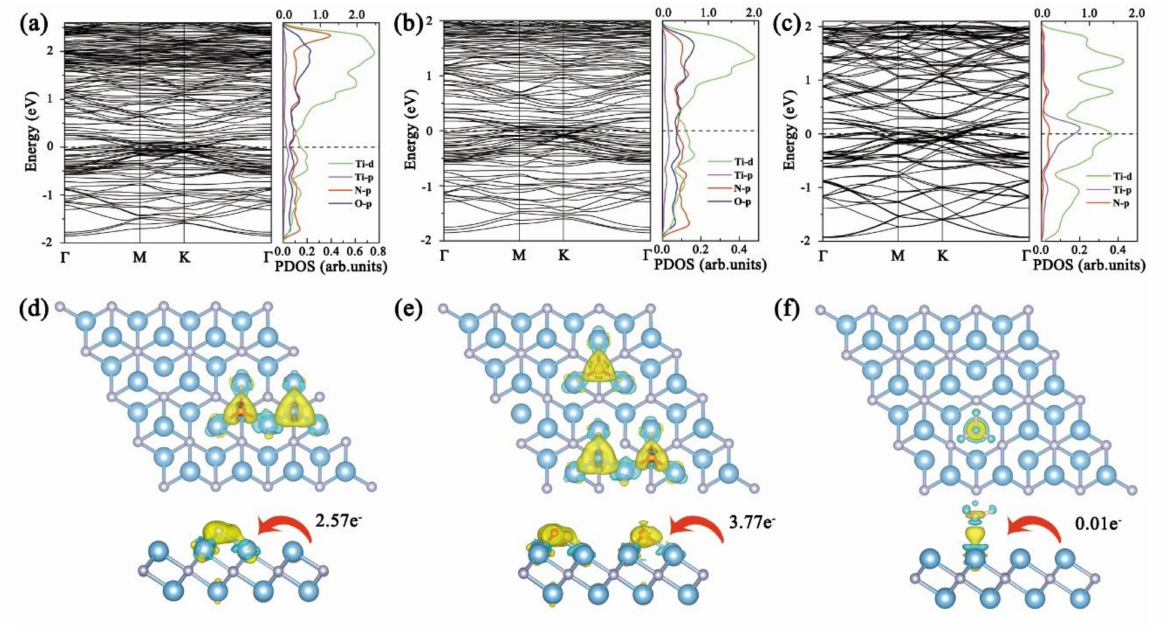
Figure 3. Band structures, PDOS and differential charge densities of Ti 2 N after adsorbing ( a , d ) NO, ( b , e ) NO 2 , and ( c , f ) NH 3 (Ti d -orbital uses top abscissa and other orbitals use bottom coordinate; isovalue of NO and NO 2 is set to 0.01 e/Å 3 , NH 3 is set to 0.005 e/Å 3